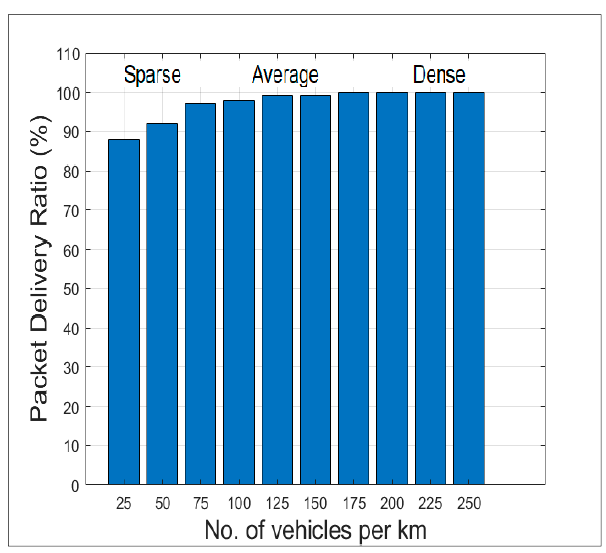
Figure 14. Packet delivery ratio versus vehicle density.